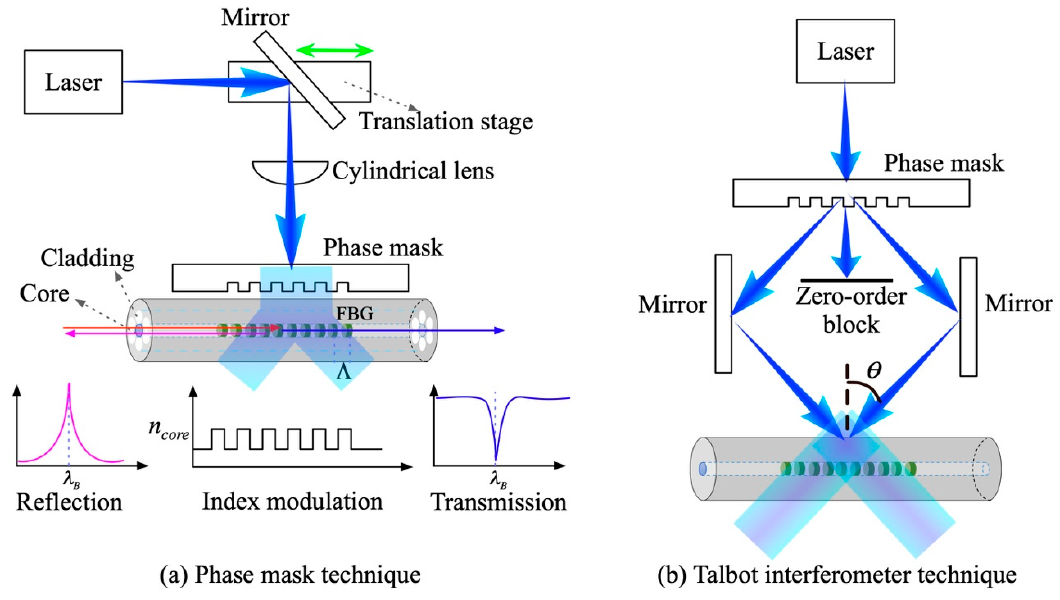
Figure 3. Schematic of the FBG inscription setup based on ( a ) the phase-mask technique and ( b ) the Talbot interferometer technique.